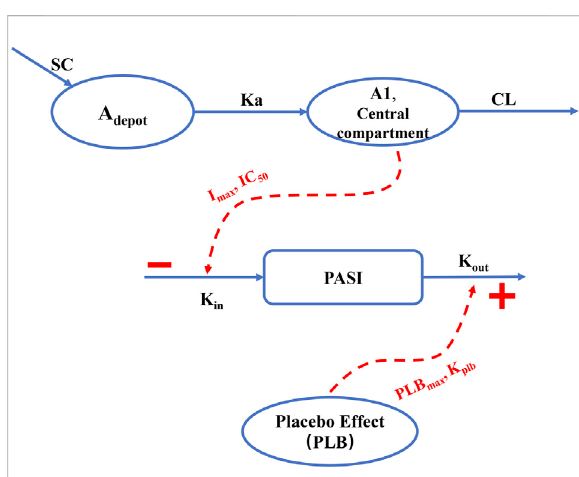
FIGURE 1 Schematicoverviewofthe fi nalpopulationPK/PD model. SC: subcutaneous injection; A depot : AK111 amounts in absorption depot; A1: AK111 amounts in central compartment; Ka: subcutaneous absorption rate constant; CL: clearance from the central compartment K in : zero-order formation rate constant for the psoriatic plaques; K out : fi rst-order degradation rate constant for the psoriatic plaques; I max : maximum inhibition effect on plaque forming rate constant; IC 50 : concentration at half- maximal inhibition; PLB max : maximum effect of placebo effect; K plb : rate constant of the reduction from the maximum placebo